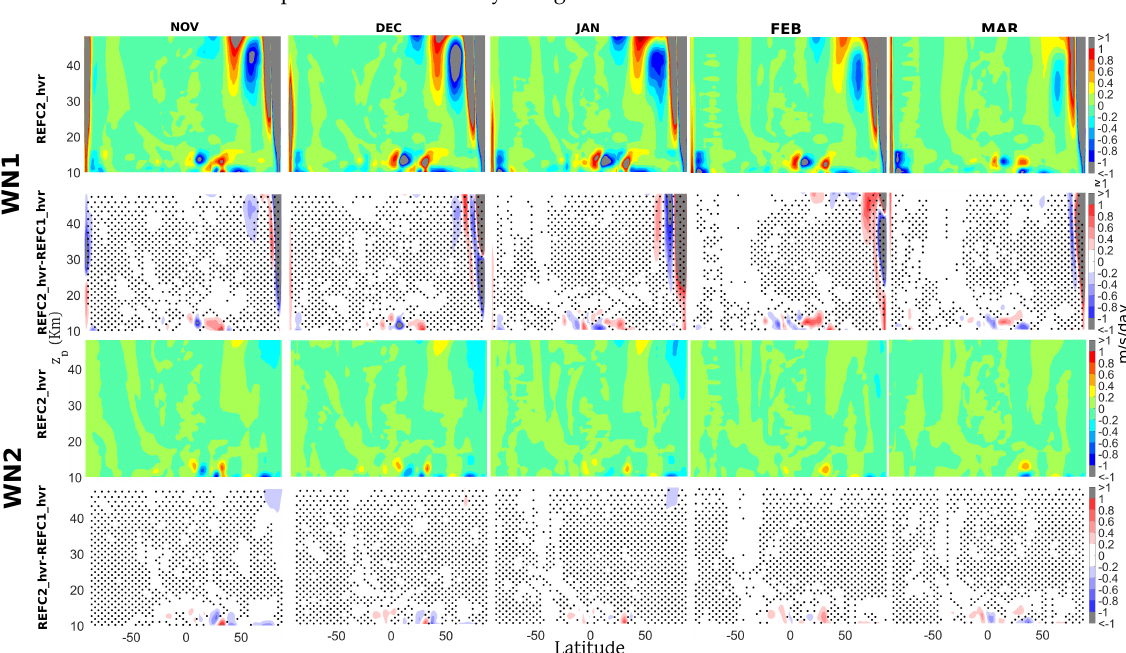
Figure 7. Monthly GWD climatology and the differences between simulations (10 km to 50 km). Contour lines are at intervals of 1 m/s/day. The statistical significance of the differences was computed in a similar way to Figure 6.